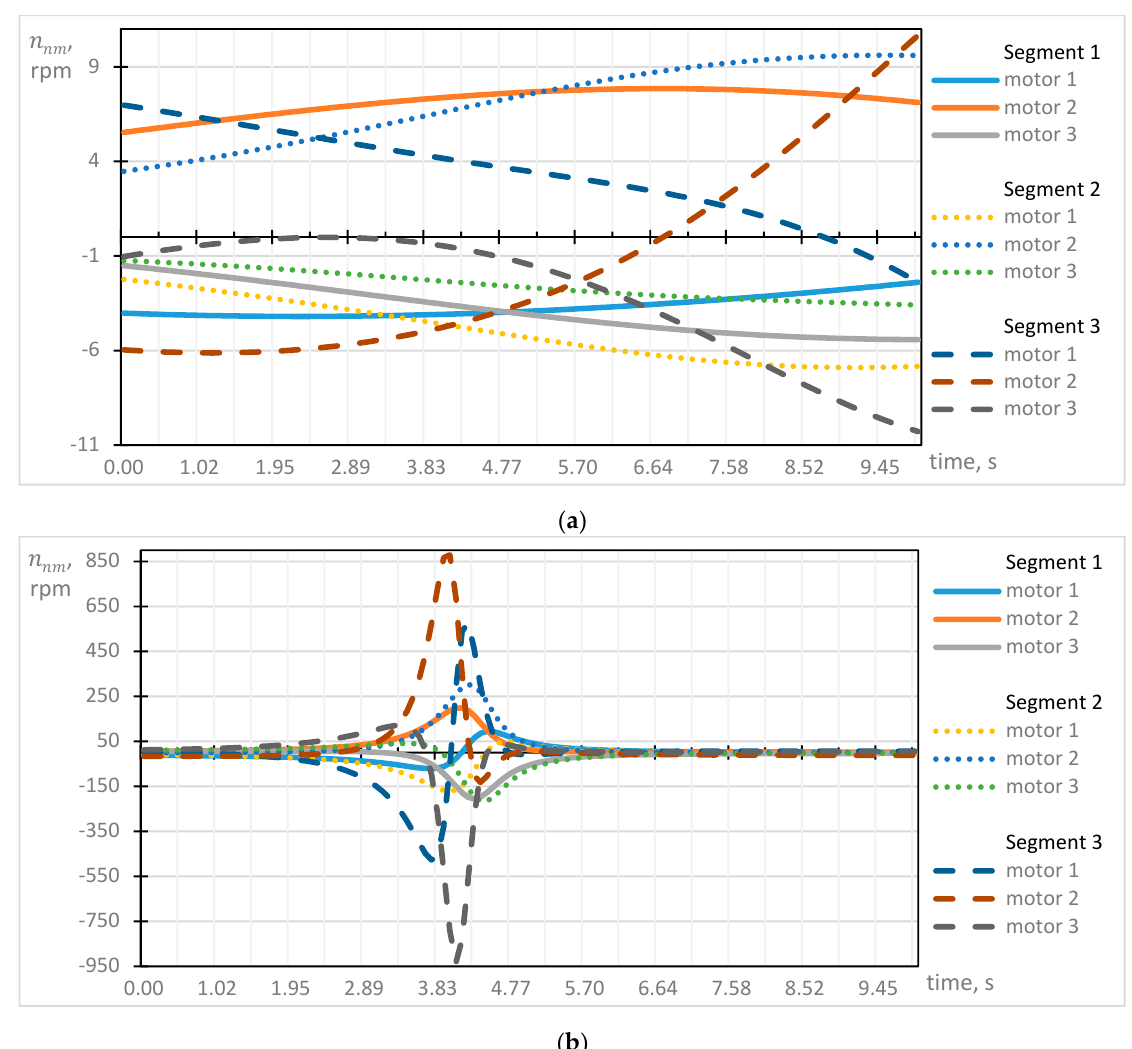
Figure 25. Motor rotational profile diagrams: ( a ) Motors’ speed profiles when the robot was straight in the initial position, scenario 1; ( b ) motors’ speed profiles, scenario 2.